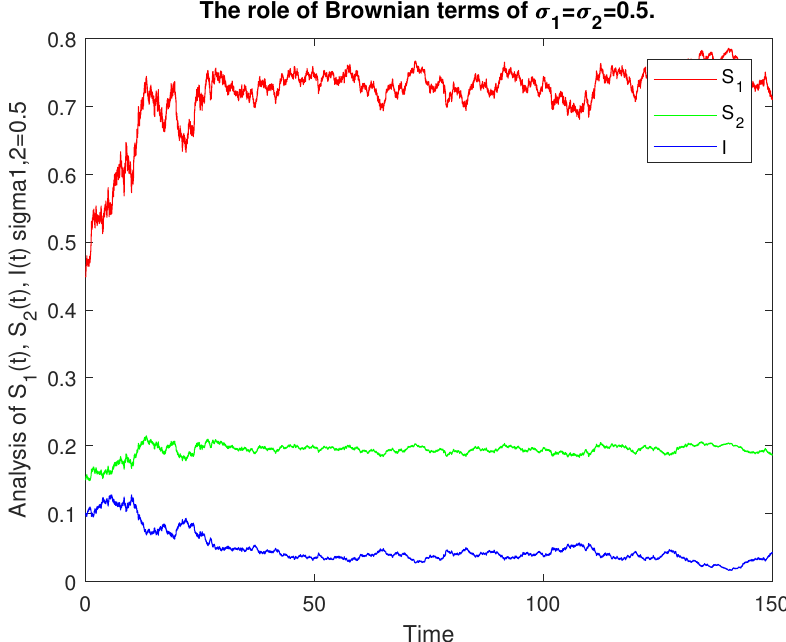
Figure 4. Numerical solution of the model (1) for σ 1 = σ 2 = 0.5.